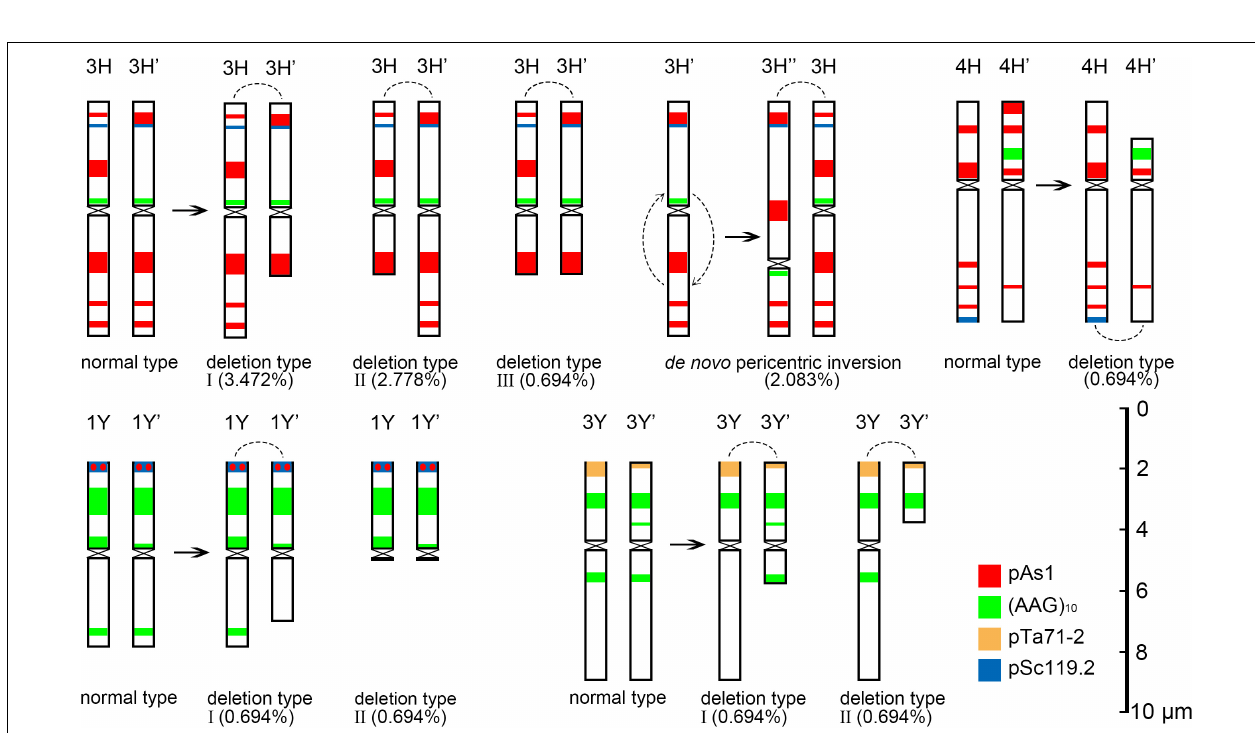
FIGURE 8 | Schematic diagram of discernible chromosomal structural variation at metaphase I. The arc is the joint position in the rod bivalent.